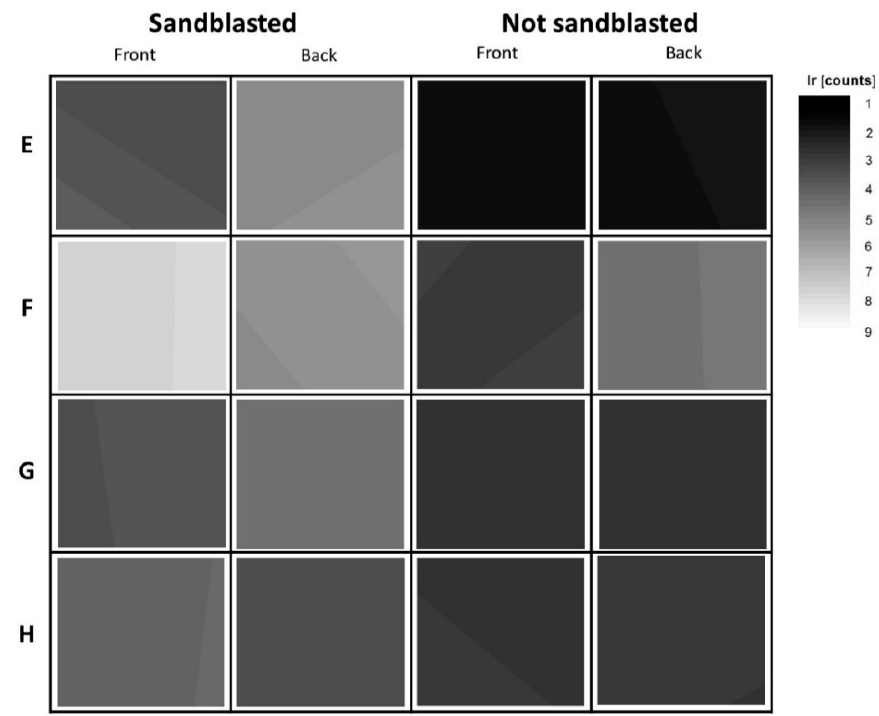
Figure 3. X-ray fluorescence (XRF) mapping of the IrO 2 samples in terms of iridium counts. Iridium counts range from 3 to 7. Darker shade means less iridium content.